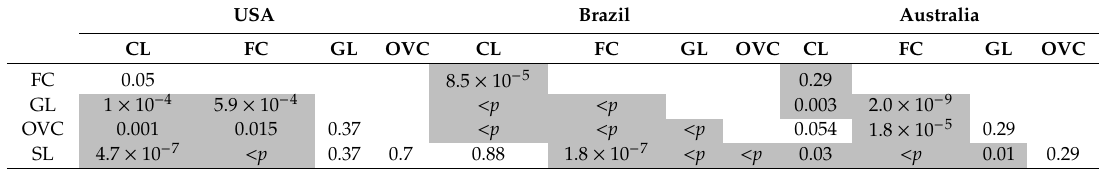
Table 2. Significance test using Kruskal-Wallis Test and class wise-comparisons of vegetation type-specific fire intensities (FRP, MW) using the Pairwise-Wilcox Test in western USA (i.e., August–September 2018), Brazil (i.e., August–September 2019) and eastern Australia (i.e., November–December 2019). Statistically significant p -values are shaded in grey. < p denotes p -value of < 2 × 10 − 16 . USA